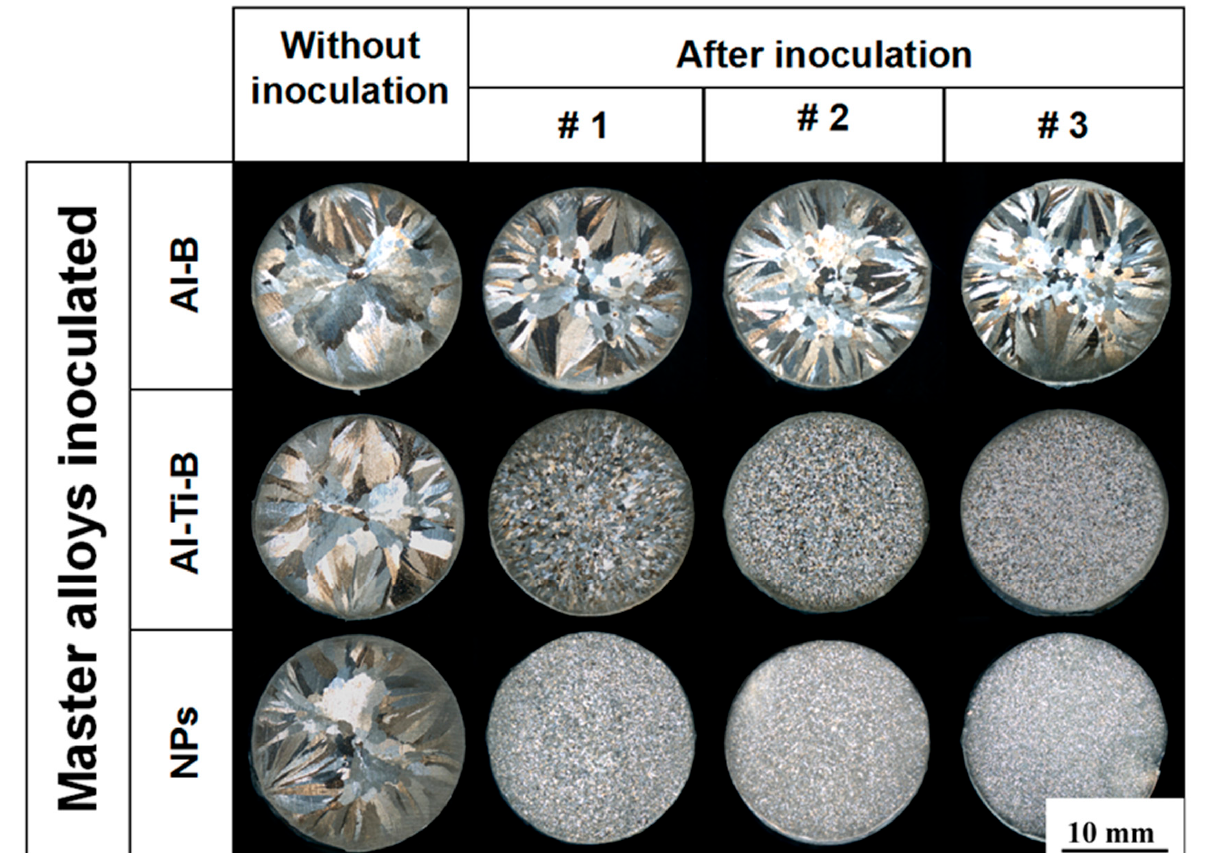
Figure 2. Comparison of NP-induced grain refinement with the conventional inoculation. For Al-B and Al-Ti-B master alloys, #1, #2, and #3 represent the addition level of 0.1 wt.%, 0.3 wt.%, and 0.5 wt.%, respectively. For NPs, #1, #2, and #3 represent the addition level of 0.5 vol.%, 1.0 vol.%, and 2.0 vol.%, respectively.